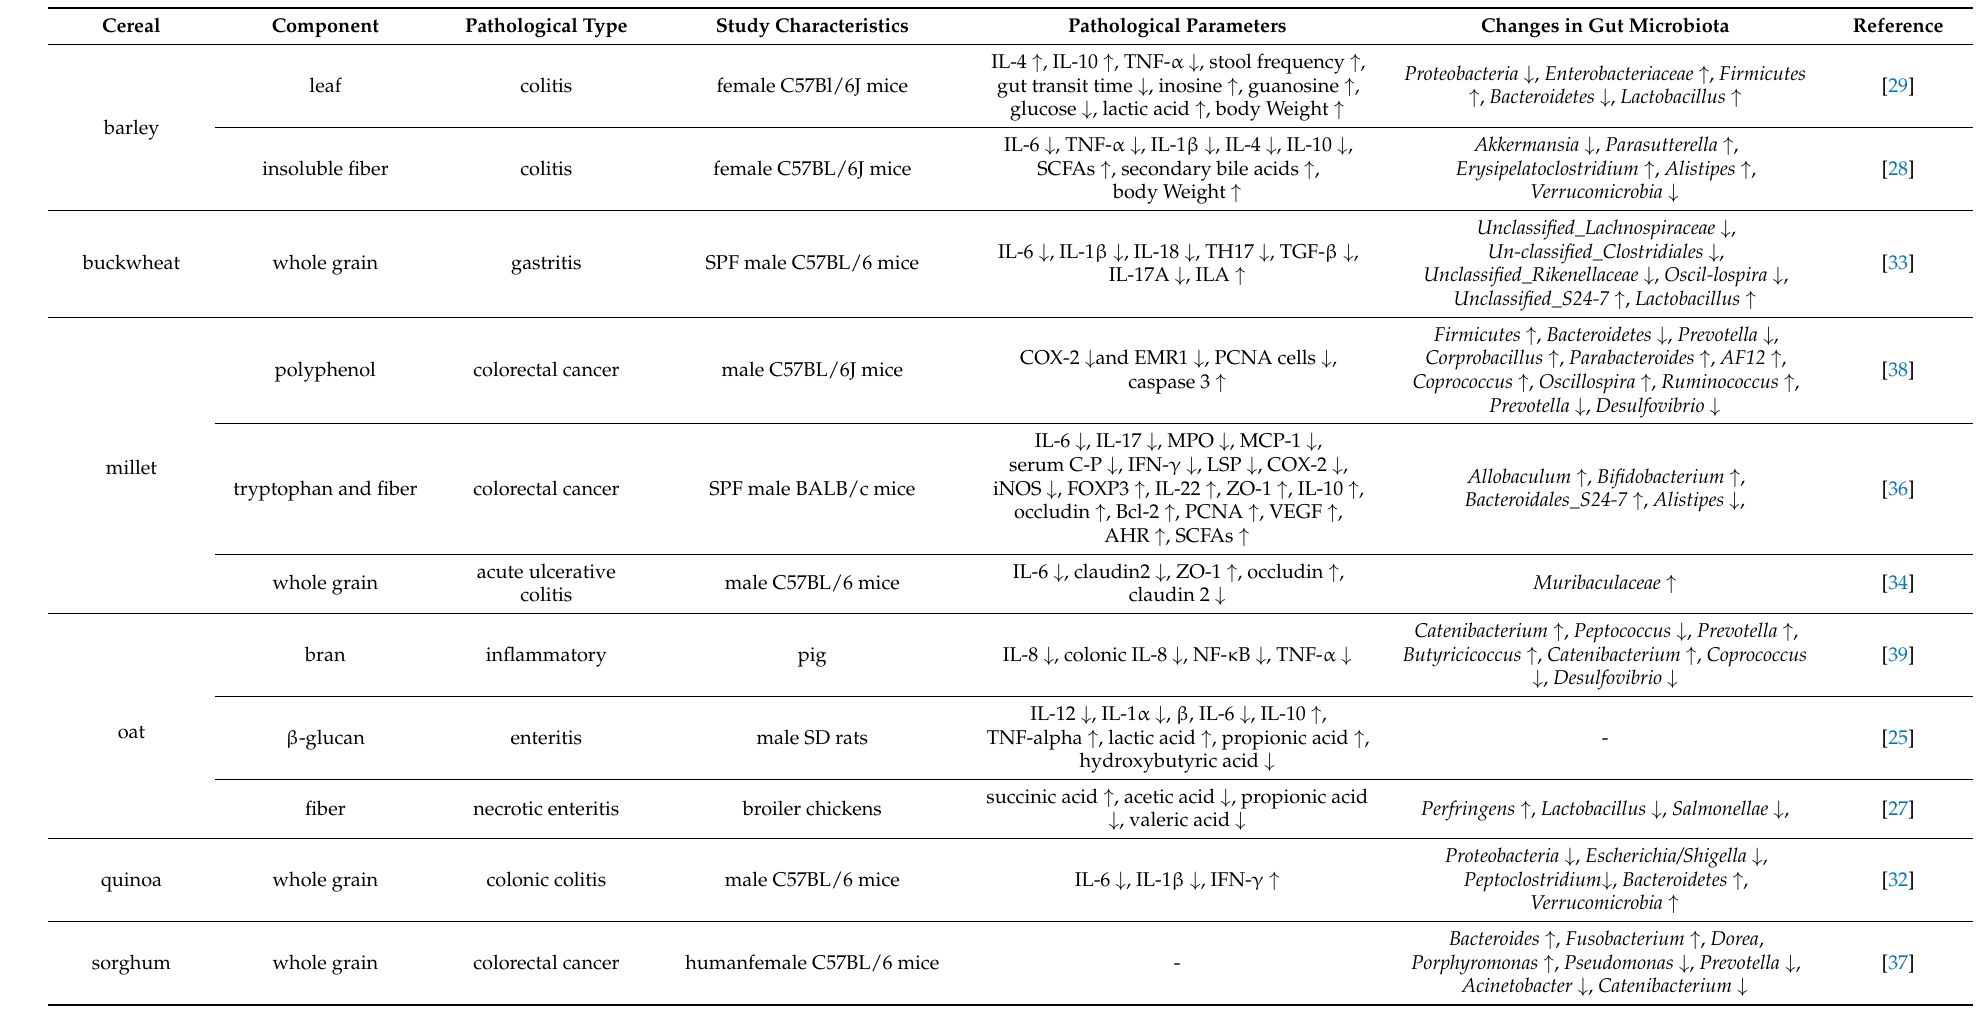
Table 1. Effect of whole-grain components on gut microbiota of gastrointestinal diseases